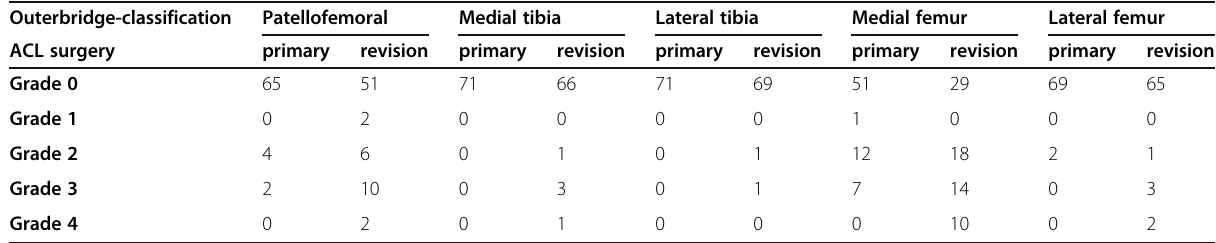
Table 3 Assessment of cartilage damage during primary and revision ACL-R according to the classification by